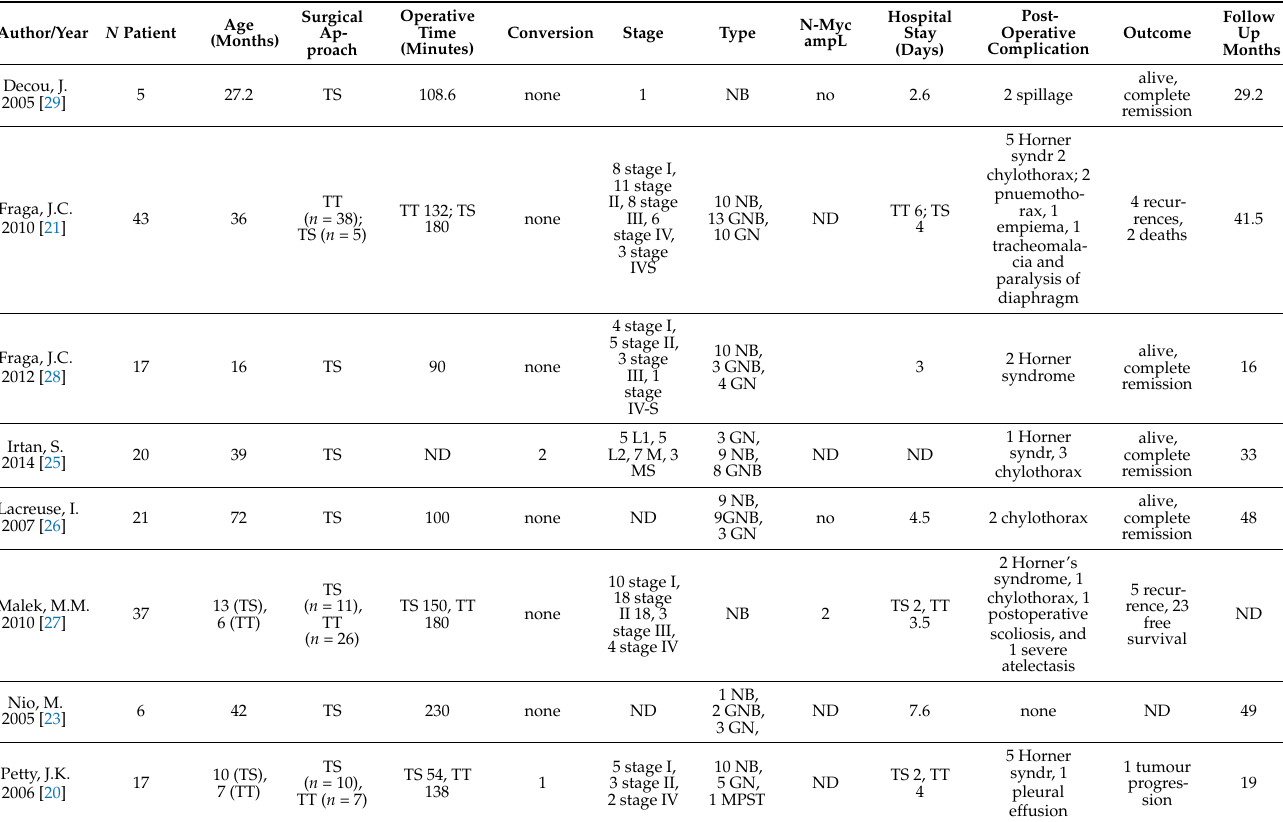
Table 1. Comparation of surgical technique for thoracic NBs. (TS = Thoracoscopic; TT = Thoracotomy; NB = neuroblastoma; GNB = ganglio neuroblastoma; GN = ganglioneuroma; MPST = Malignant peripheral nerve sheath tumor ND = not defined). Author/Year N